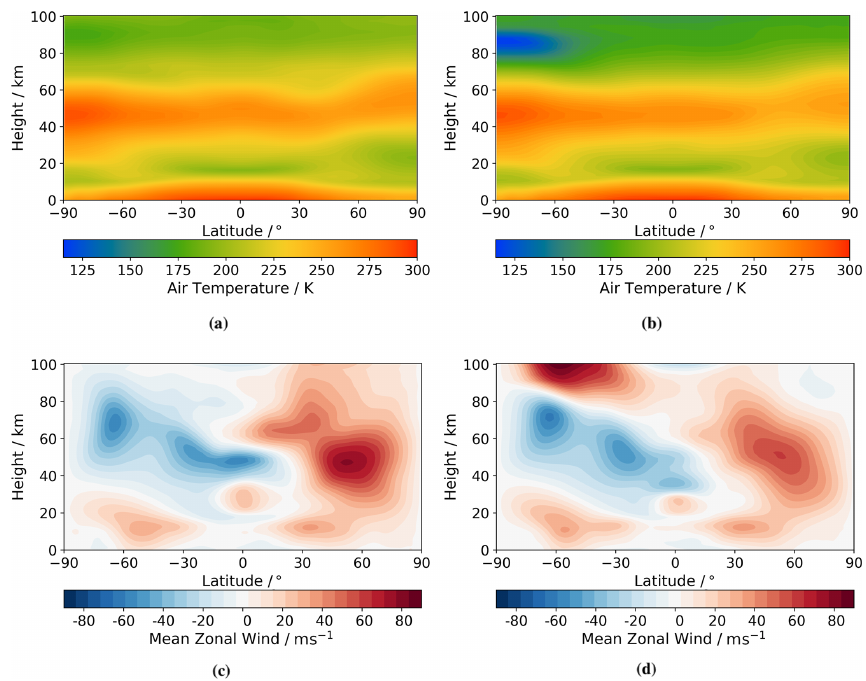
Figure 1. Latitude–height zonal-mean monthly-mean climatologies in December comparing (a) ExUM temperature before with (b) ExUM temperature after the non-LTE implementation. Also compared is (c) ExUM zonal ( u ) wind before with (d) ExUM zonal ( u ) wind after the non-LTE implementation. The more accurate modelling of the summertime polar mesopause minimum is evident upon introduction of the non-LTE radiation scheme with consequent effect on the modelled winds in the MLT.